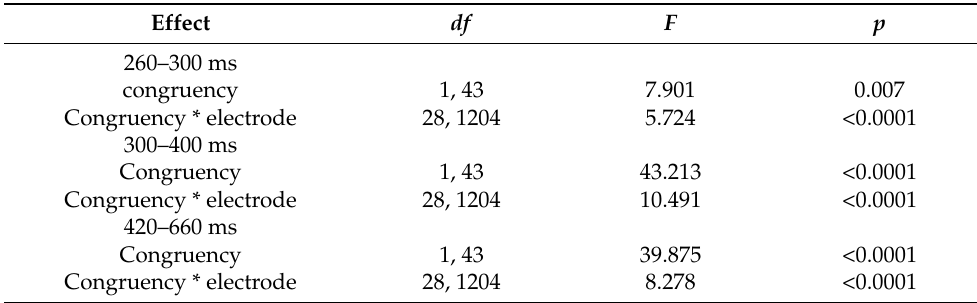
Table 2. Significant ERP results of the ANOVAS with the factors congruency * electrode * group for all selected time windows.